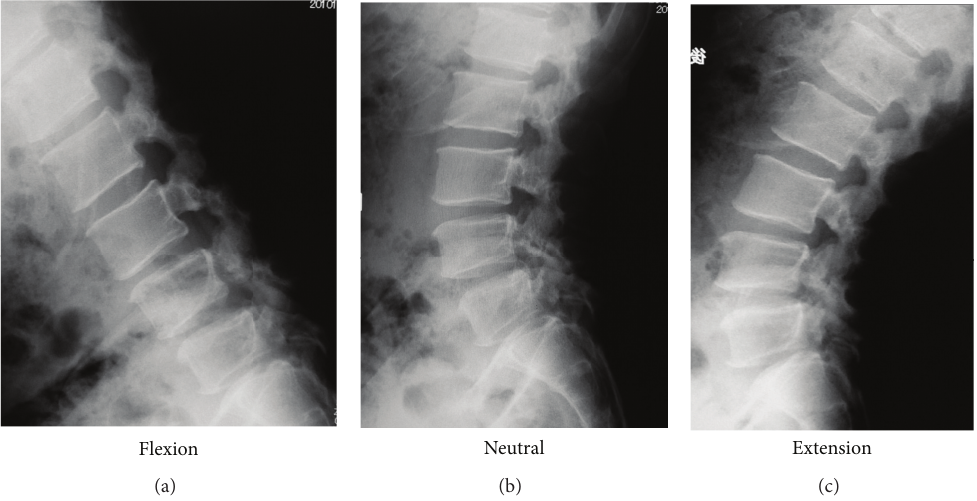
Figure 2: Plain dynamic film at initial presentation shows no obvious instability.